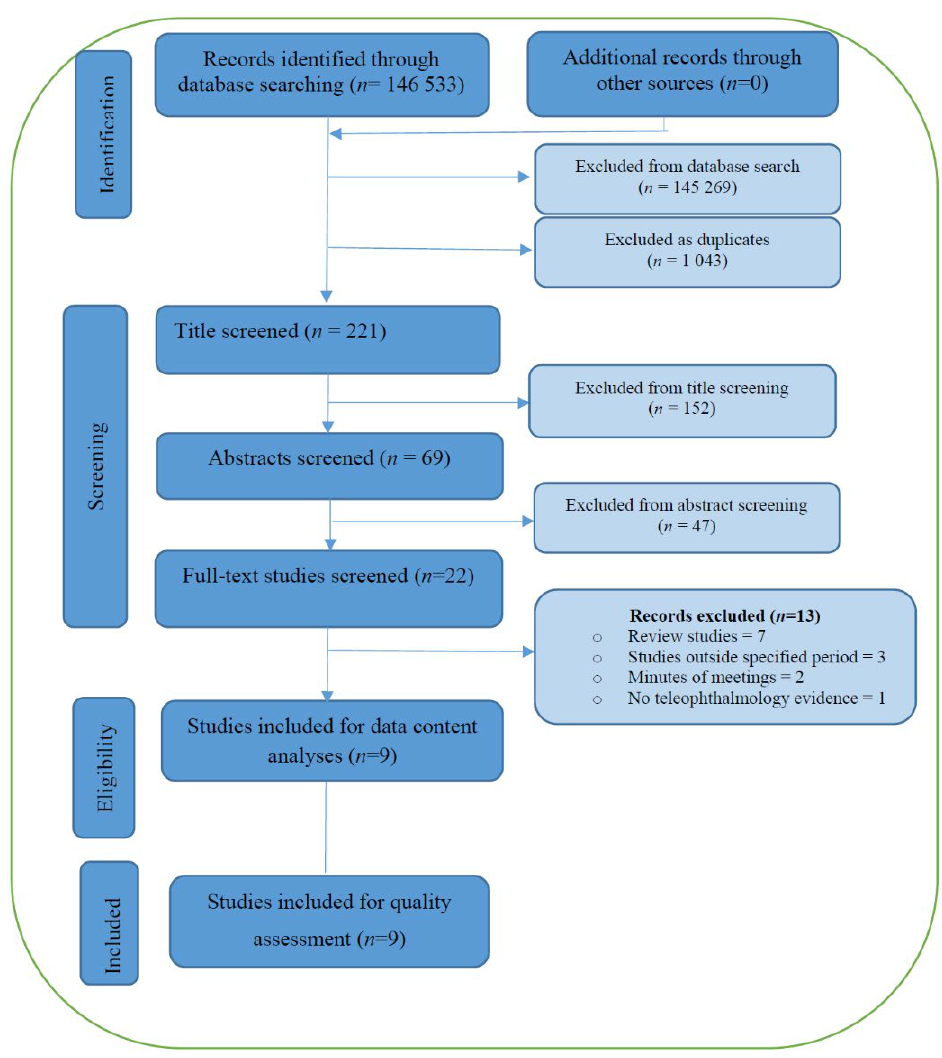
Figure 1. PRISMA flow diagram.